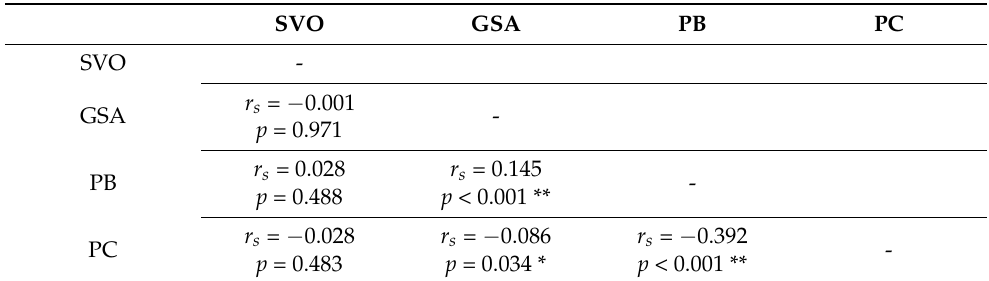
Table 2. Correlation matrix between prosocial behaviors, GS attendance, perceived beauty of the GS, and perceived crowdedness of the